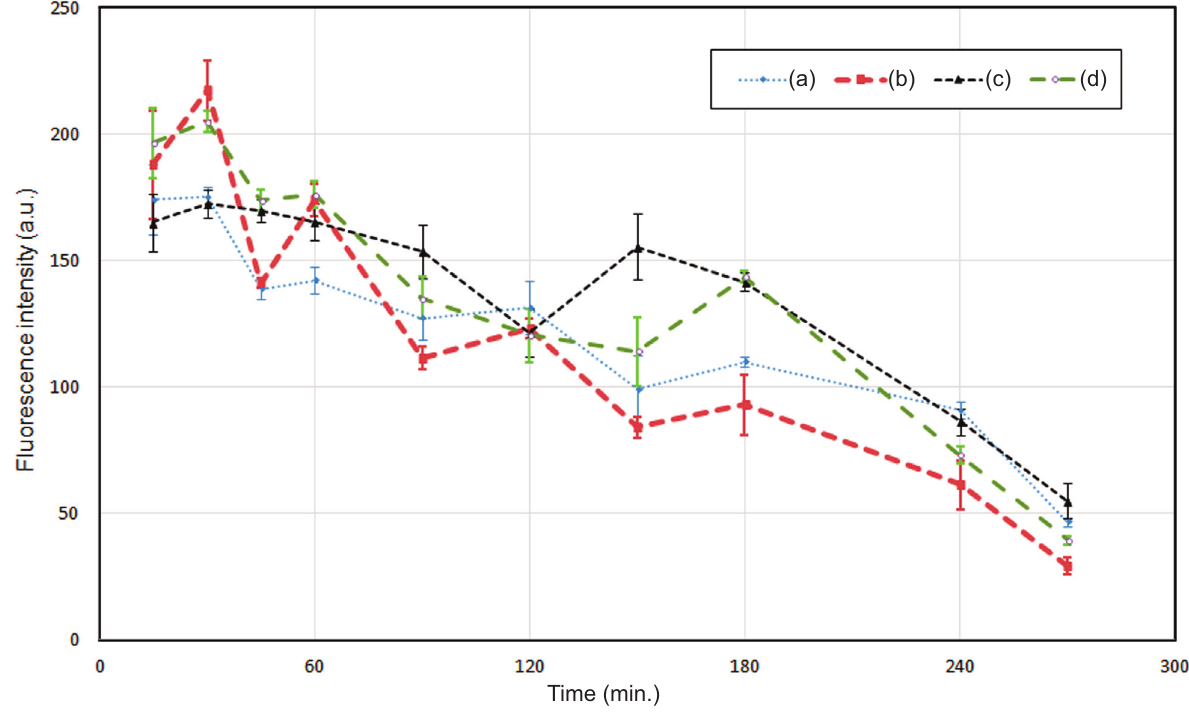
Time Fig. 4. Persistent fall­off of tryptophan fluorescence peak at ~280 nm / 330 nm after the long­term HPV decontamination procedure studied by using the response of G. stearo thermophilus spores: (a) spectrofluorometer measurement result for unwrapped sample; (b) H2BM fluorometer result for unwrapped sample; (c) spectrofluorometer result for unopened sample; (d) H2BM fluorometer result for unopened sample. Wrapping in Tyvek pouch does not hinder the effect of HPV.